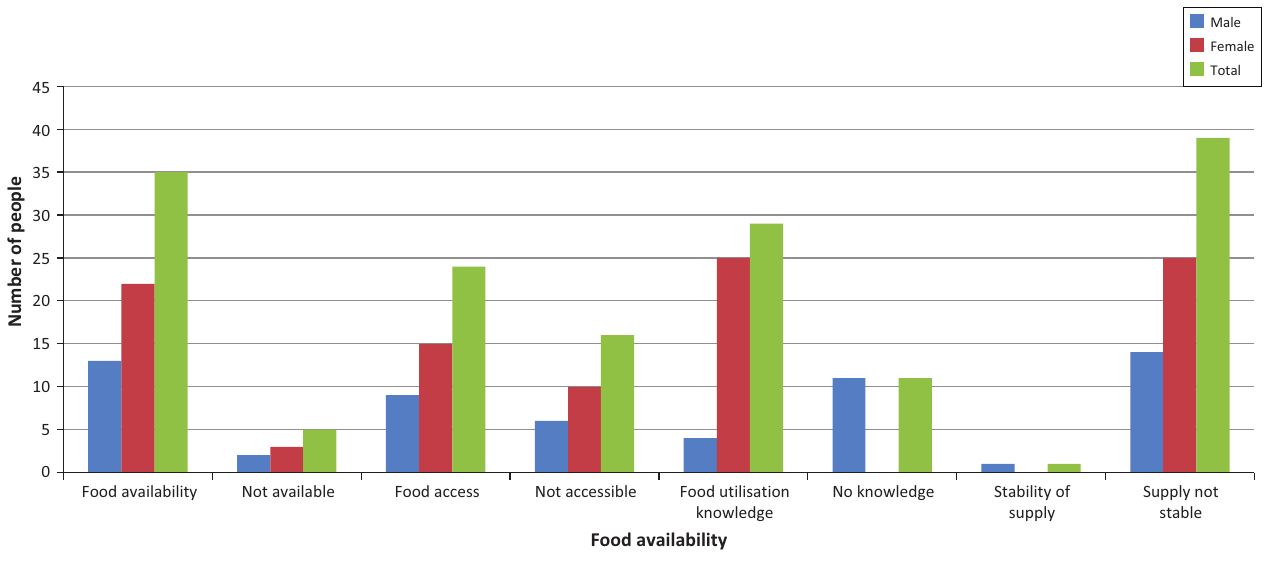
FIGURE 5: Food availability, access, utilisation and stability of supply.